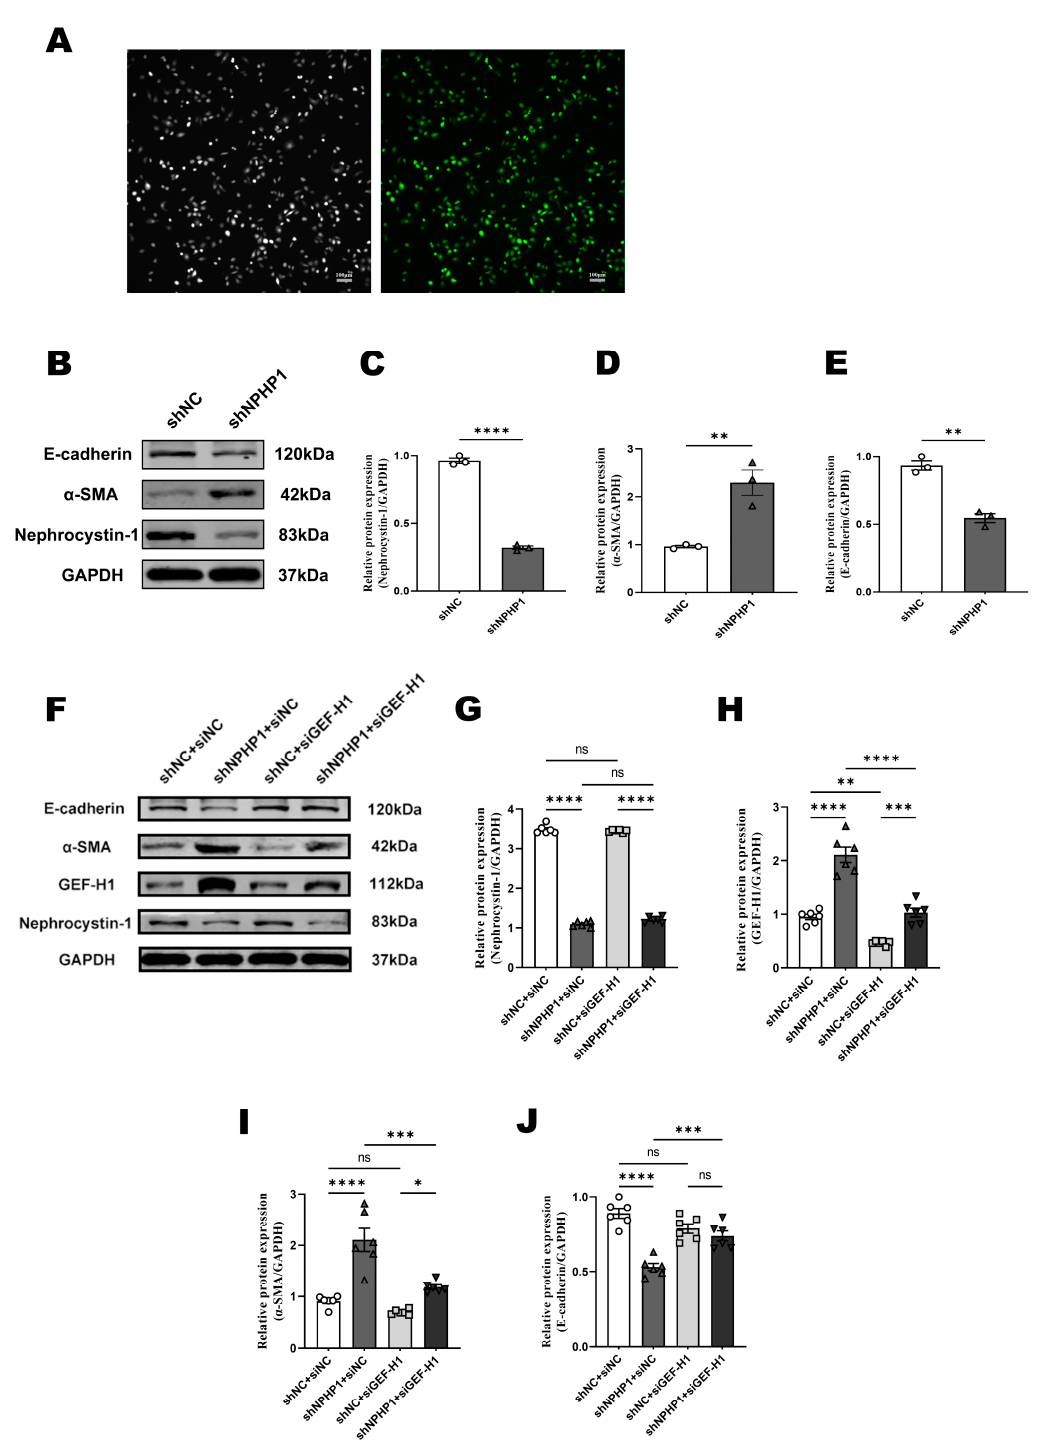
Figure 4. GEF-H1 knockdown alleviated epithelial-mesenchymal transition in NPHP1 KD HK2 cells. ( A ): eGFP was observed using fluorescence microscopy in HK2 cells transfected with lentivirus carrying shNPHP1. The left panels show the corresponding bright-field images of the cells. Scale bar = 100 µ m. ( B – E ): Expression of nephrocystin-1, α -smooth muscle actin ( α -SMA), and E-cadherin in HK2 cells ( B ): Western blot, ( C – E ): Densitometry analysis; n = 3 technical replicates). ( F – J ): Expression of GEF-H1, nephrocystin-1, α -SMA, and E-cadherin in HK2 cells ( F ): Western blot, ( G – J ): Densitometry analysis; n = 6 technical replicates. Data represent the mean ± SEM. * p < 0.05; ** p < 0.01; *** p < 0.001; **** p < 0.0001; ns, no significance. 2.4. The GEF-H1/RhoA Pathway Was Associated with MLC2 Phosphorylation in NPHP1 KO Mice MCL2 is a downstream target of the GEF-H1/RhoA pathway and is a regulator of cell cytoskeletal reorganization, cell morphological changes, and inflammation [36]. To deter- mine if MLC2 was activated in NPHP1 defects, we measured the phosphorylation of MLC2 (p-MCL2) in the kidneys of NPHP1 KO mice. As expected, p-MCL2 was upregulated